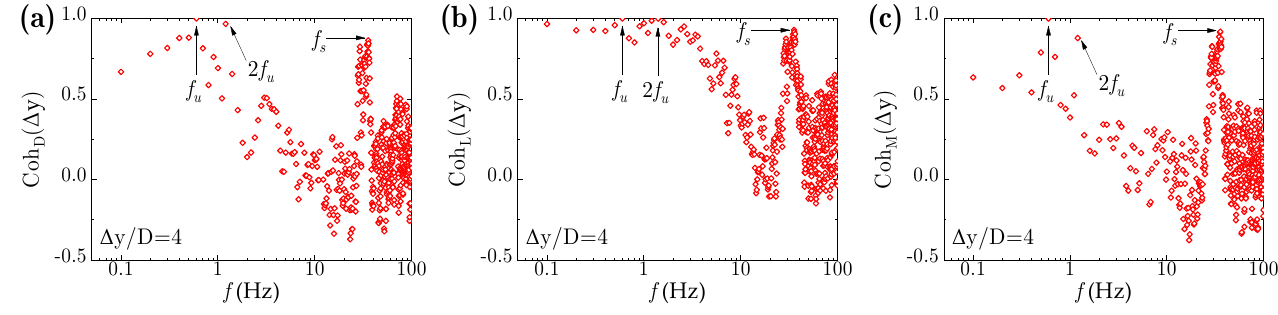
Figure 14. Coherence functions of ( a ): C D , ( b ): C L , and ( c ): C M in SF (0.6, 0.125) at AoA = 4°.